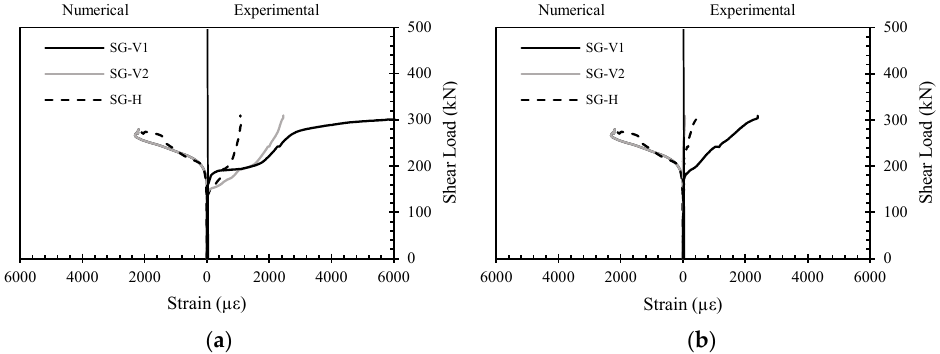
Figure 10. Numerical and experimental stirrup strain response of SR0-SF0-S: ( a ) west shear span; ( b ) east shear span.